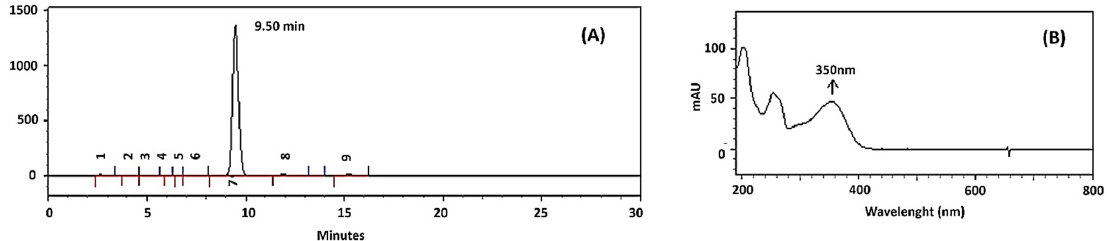
Figure 3. HPLC chromatogram ( A ) and UV-Vis spectrum ( B ) of the isolated RUT from D.